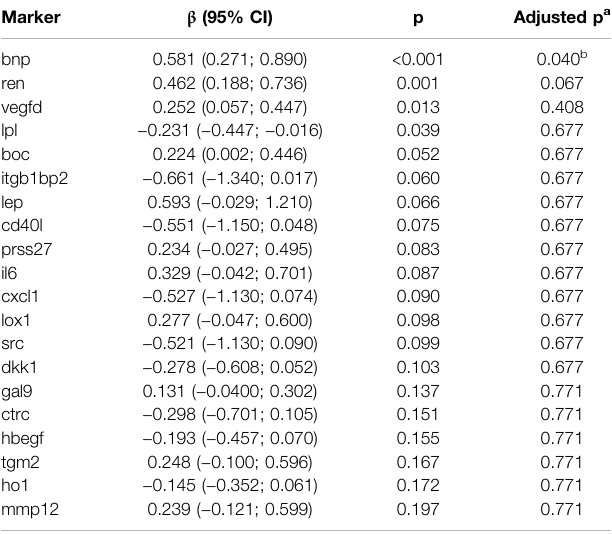
TABLE 4 | Results from linear regressions models comparing each biomarker between MFS and controls, adjusting for age and sex.